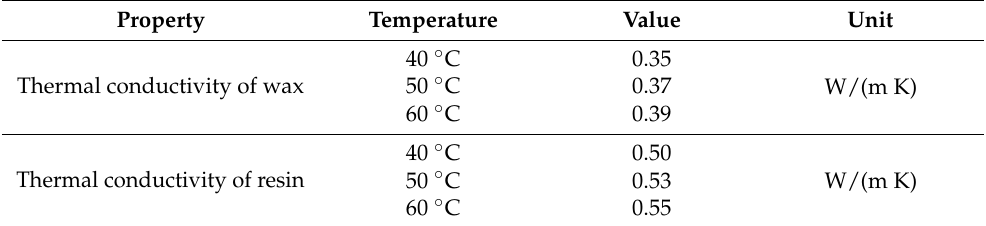
Table 3. The measured values of thermal